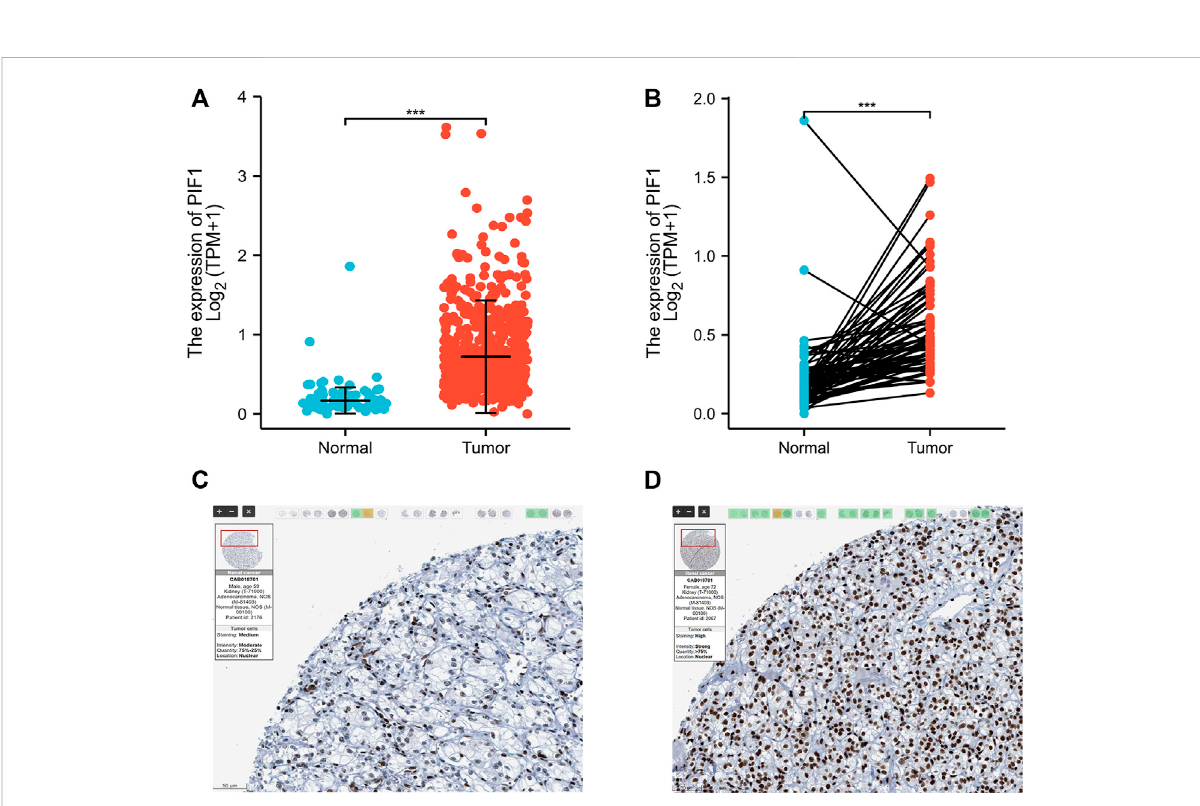
FIGURE 2 ThemRNAandproteinexpressionofPIF1inccRCC. (A) mRNAexpressionlevelsofPIF1in611ccRCCsamplesand72normalsamples. (B)